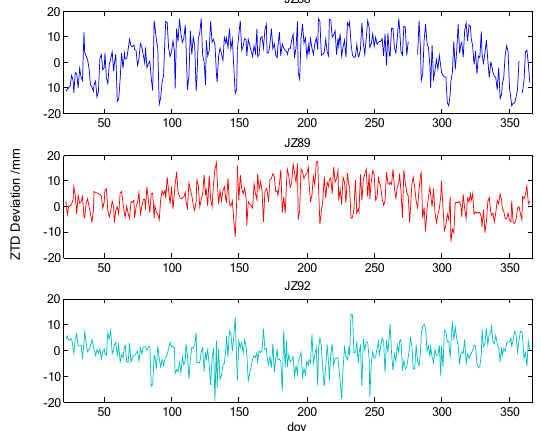
doy Figure 6 Deviations between ZTD of Check Stations Estimated by New Model and True Value Among 8 fitting stations, the maximum deviation of the ZTD occurred at the jz85 station, namely 18.80mm. Except for JZ86, Figure 4 Deviations between ZTD of Fitting Stations Estimated the proportion of the deviations within [1,5]mm at each fitting by New Model and True Value station increased in turn with the elevation, and the RMS also decreased with the elevation; among 3 check stations, the deviations between the estimated value and the true value within [1,5]mm accounted for 71.1% at the jz88 station with the maximum elevation, and the RMS was 5.44. Besides, its precision was significantly increased with the elevation.